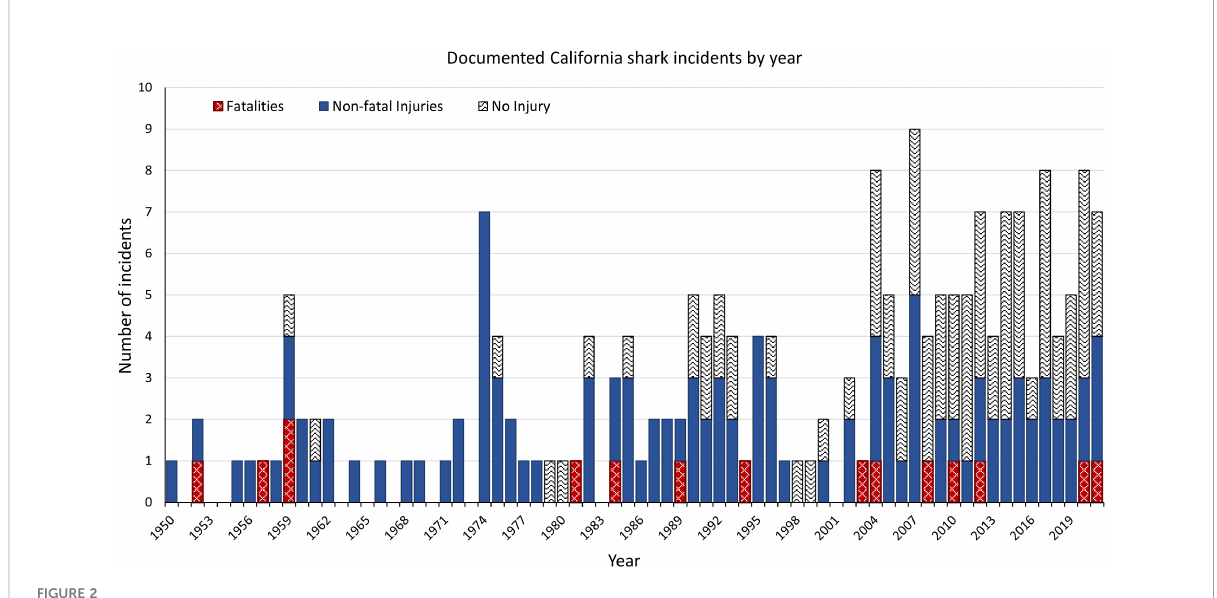
FIGURE 2 Documented California shark incidents in California by year, 1950 to